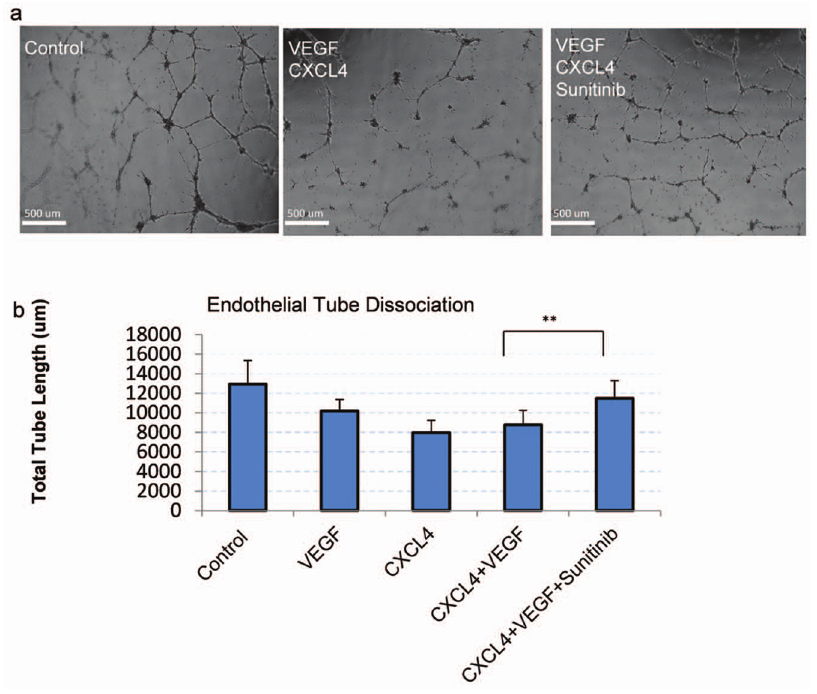
Figure 1. VEGFR inhibition decreases CXCL4-induced cord dissociation. a) Representative phase contrast images of HMEC cells treated with indicated treatments are shown. Images were taken of live cords after 24 hours. Disruption in webbed patterning of cells indicates increased dissociation. b) Images described in ( Fig 1a ) were quantified as described in methods using Metamorph analysis software (N at least 4; mean 6 SD, ** P , 0.05), Shown are representative of 3